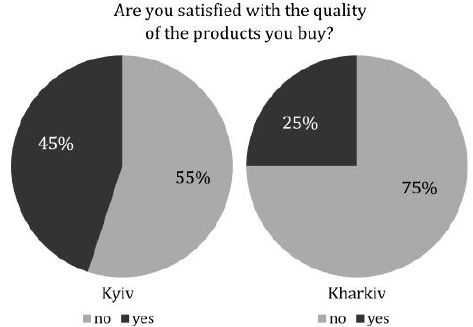
Fig. 2. Level of satisfaction of respondents with quality of consumer goods (Source: author's research)